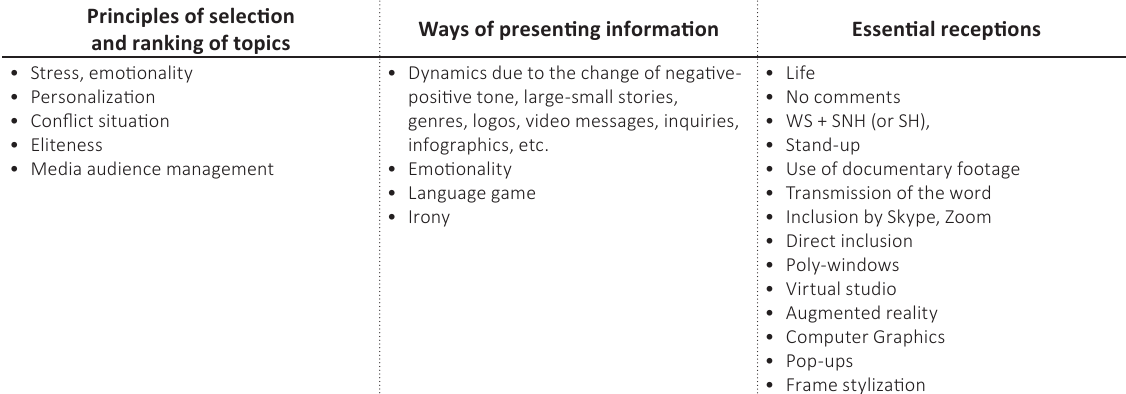
Table 6. Structural model of mixed TV layout Principles of selection and ranking of